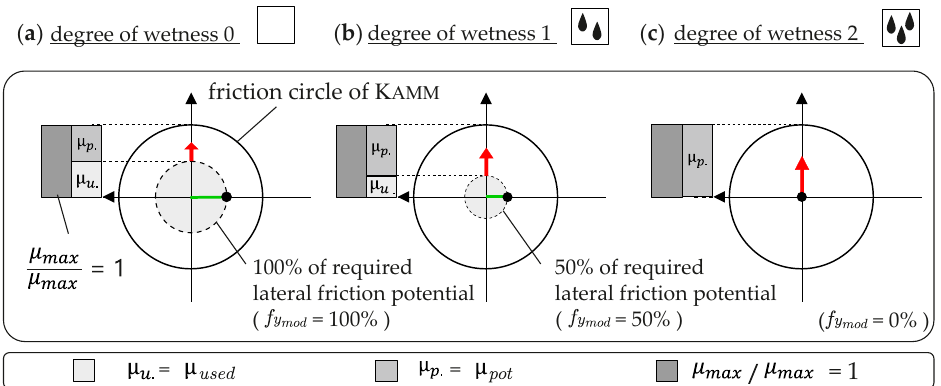
Figure 5. Concept idea—variable consideration of the required lateral friction potential of the front axle tyres depending on the assumed degree of wetness.